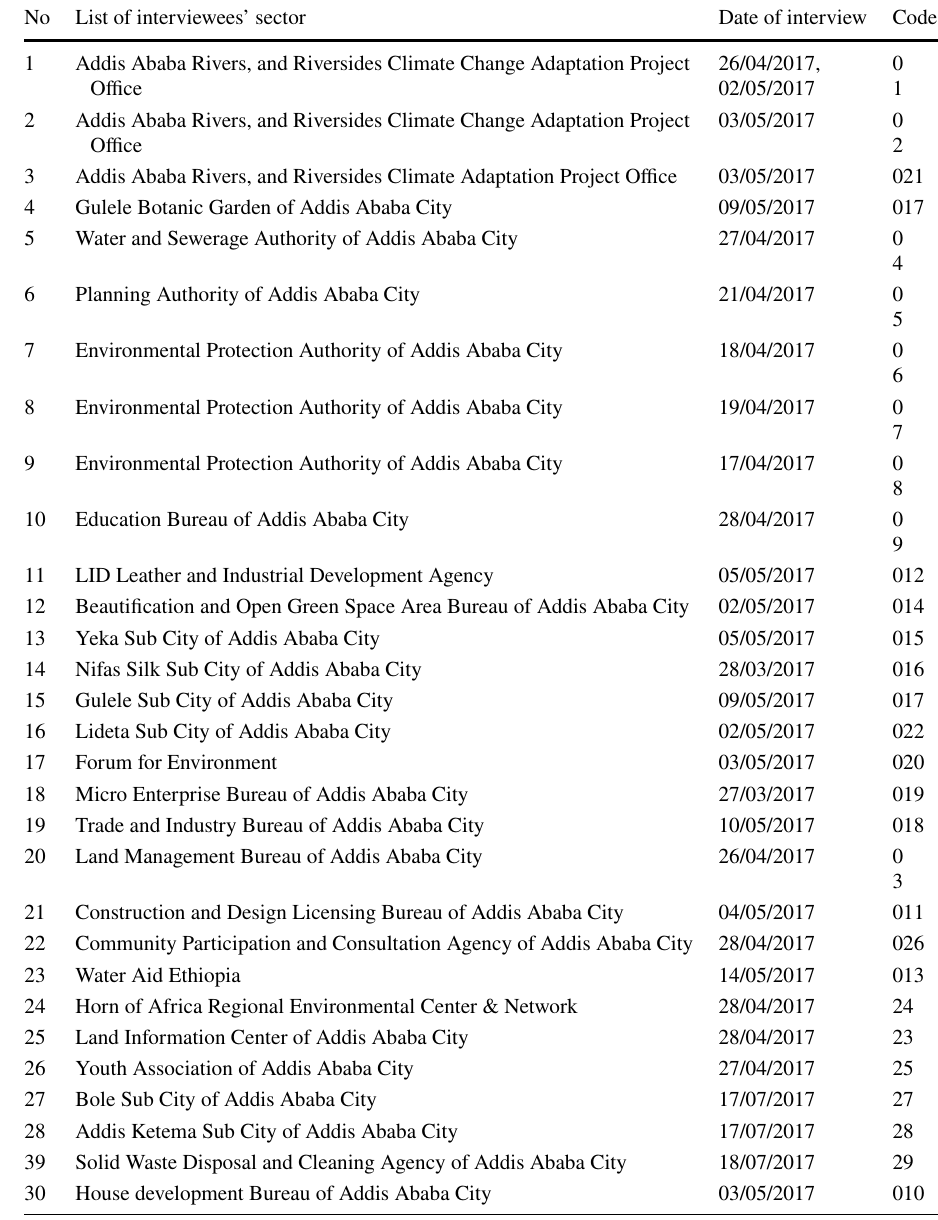
Table 2 The list of interviewees and their sector Source Addis Ababa Environmental Protection Authority (2017)